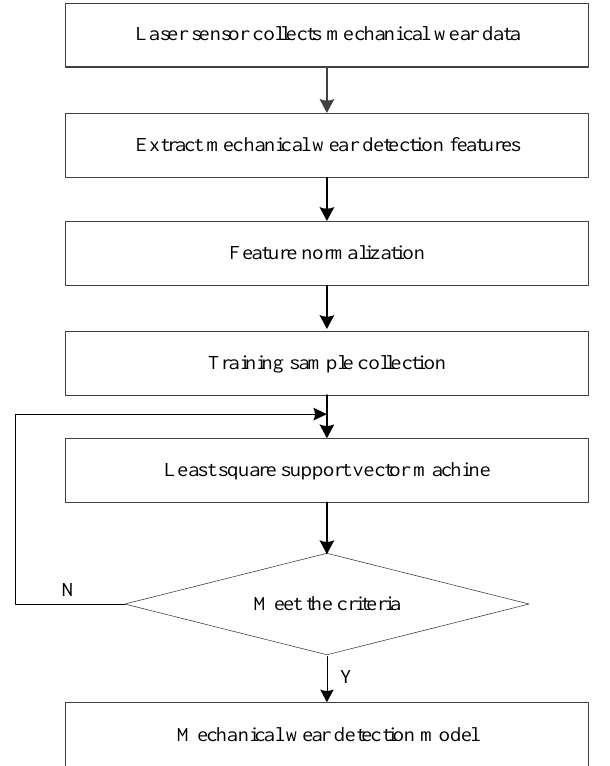
Figure 1. Working principle of mechanical wear detection model.